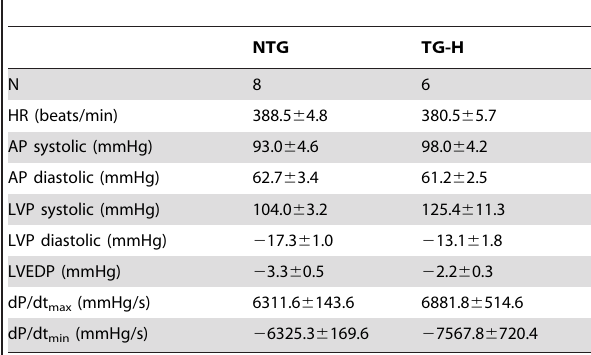
Table 2. M-mode echocardiograms.